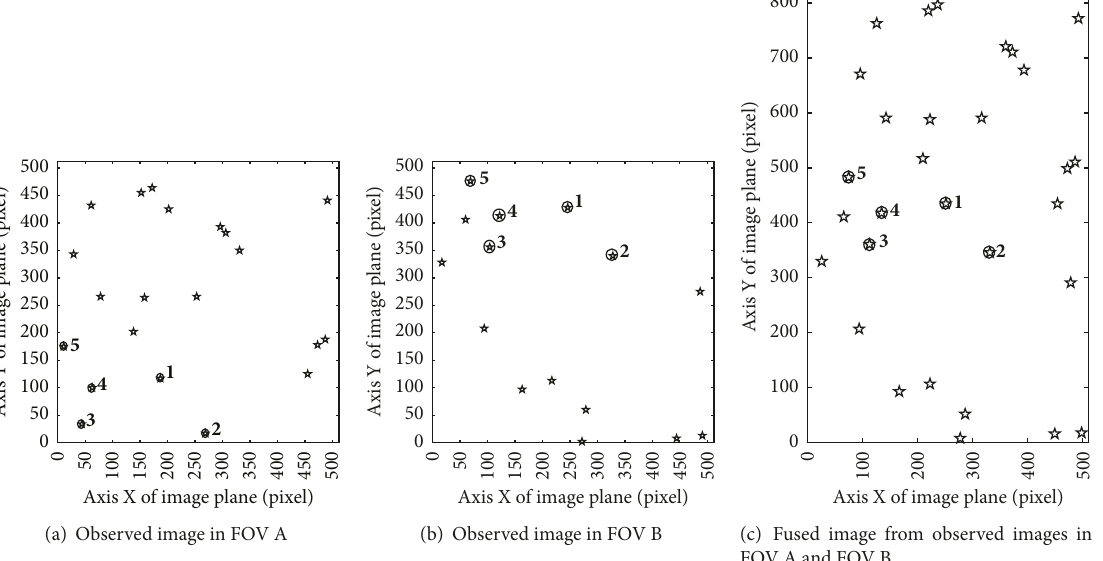
Figure 1: Observed star images in various fields of star